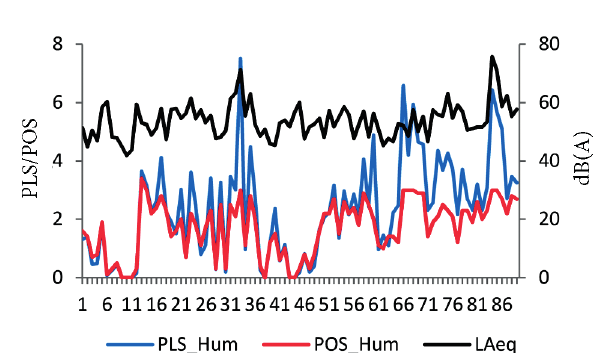
Fig. 4. Perceived loudness and occurrences of human sounds along with sound pressure level (L